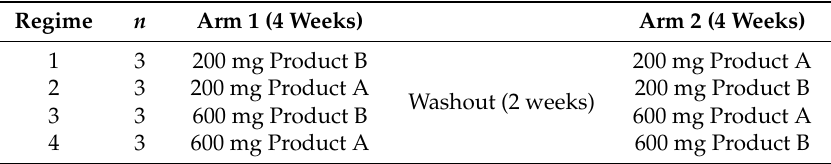
Table 1. Regimen and dosages of assigned products. Product A: Standard lactoferrin; Product B: Inferrin TM